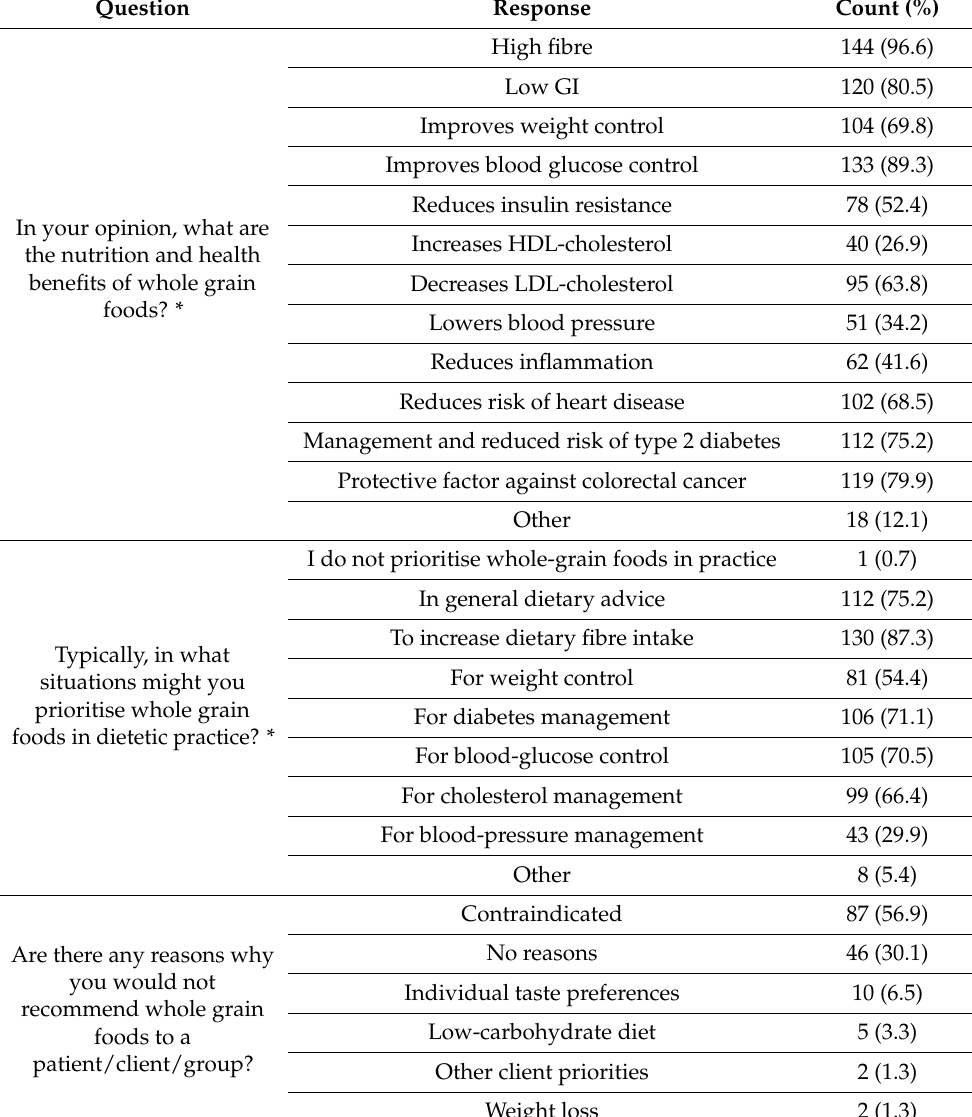
Table 3. Dietitians’ understanding of the benefits of whole grains and situations in which they should be